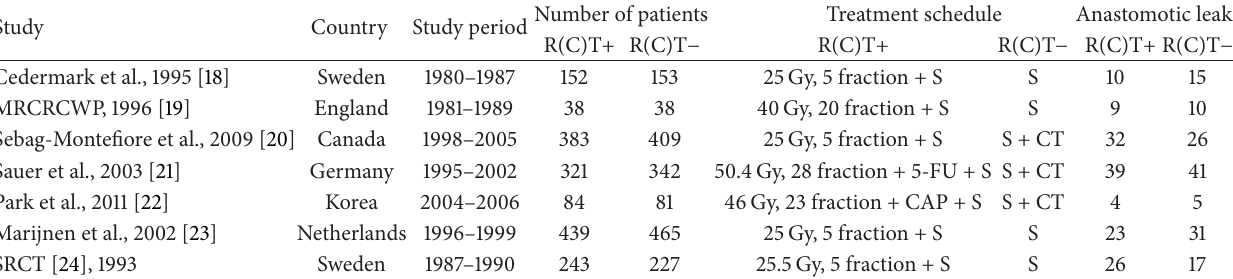
Table 1: Baseline characteristics of studies included in the systematic review.